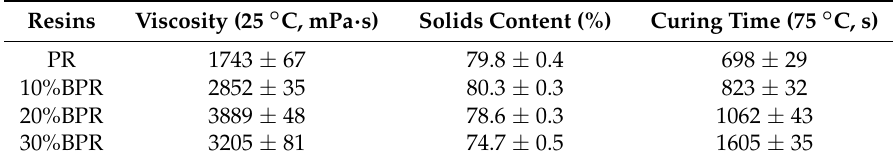
Table 1. Basic characteristics of phenolic resin (PR) and bio-oil phenolic resin (BPR).